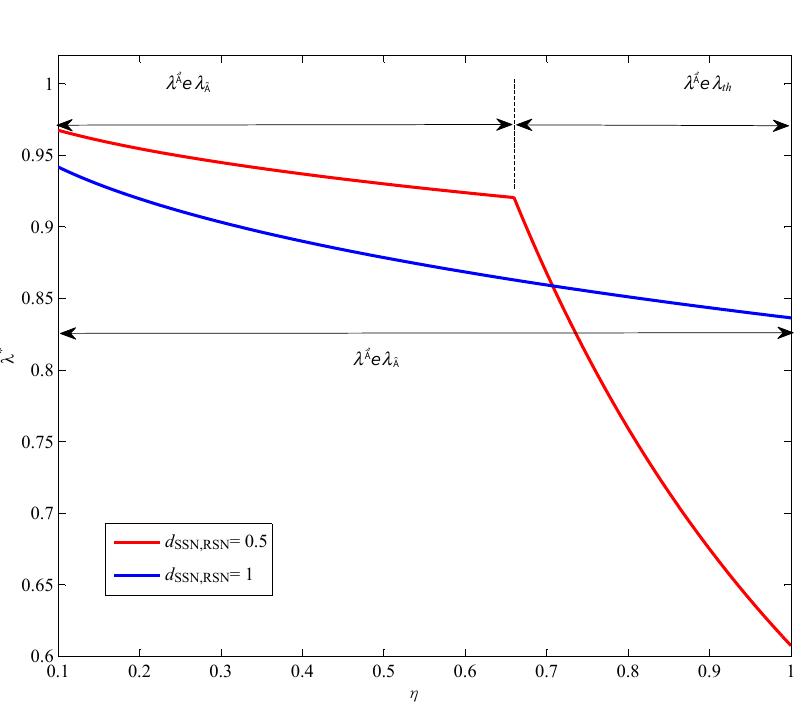
Figure 9. The optimal value of λ versus η